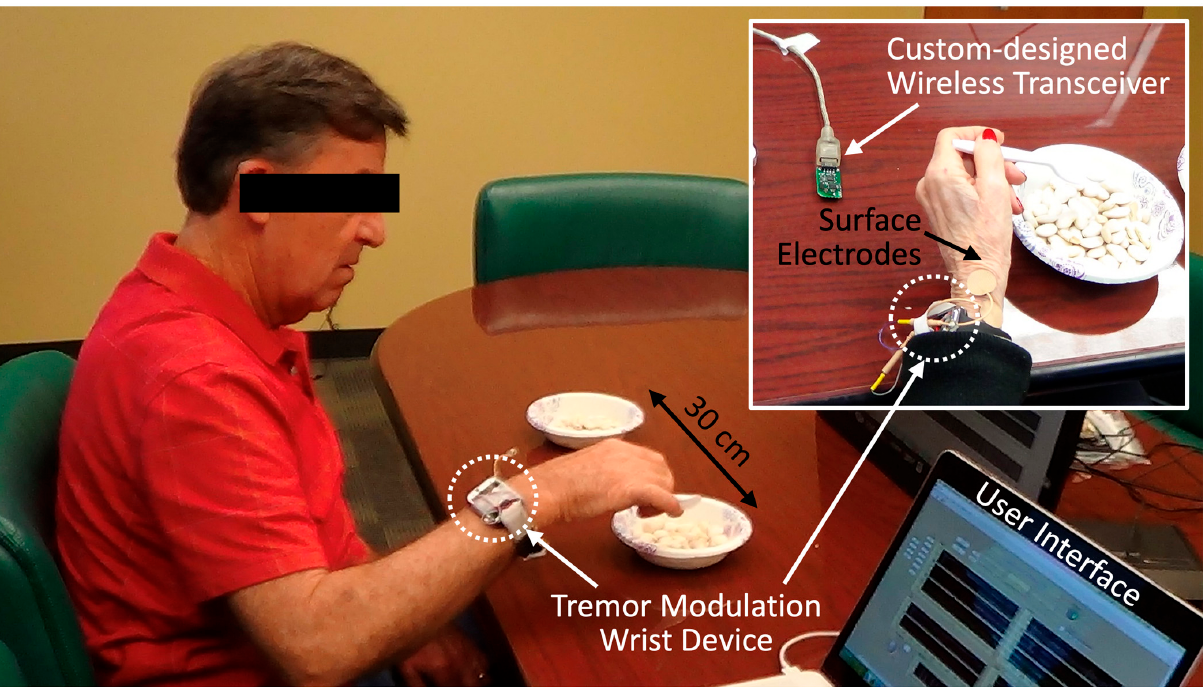
Figure 2. Experimental setup for peripheral nerve electrical stimulation using the wrist device while one of the participants performed the bean-transfer task.